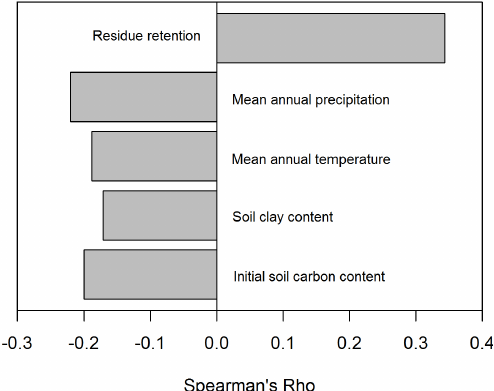
Figure 4. Spearman’s rank correlation coefficients between SOC change (1961–2014, MgCha − 1 ) and residue retention and soil and climate variables. All tests were significant ( P < 0 .